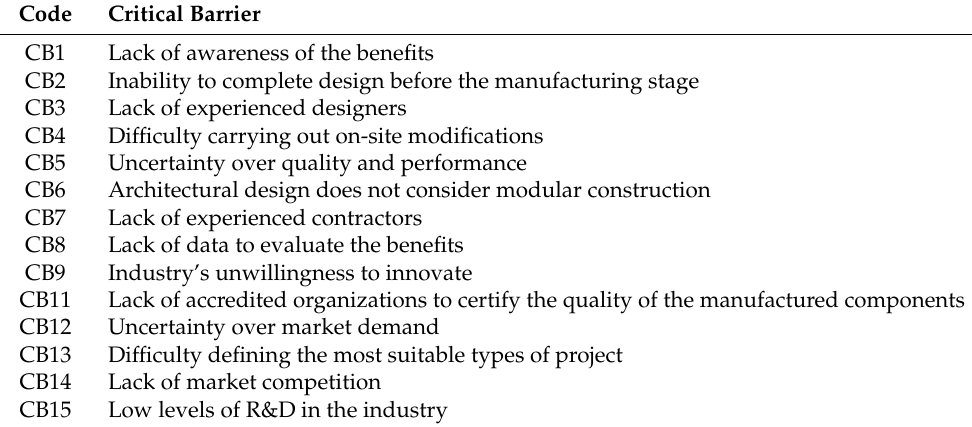
Table 3. Critical barriers to the